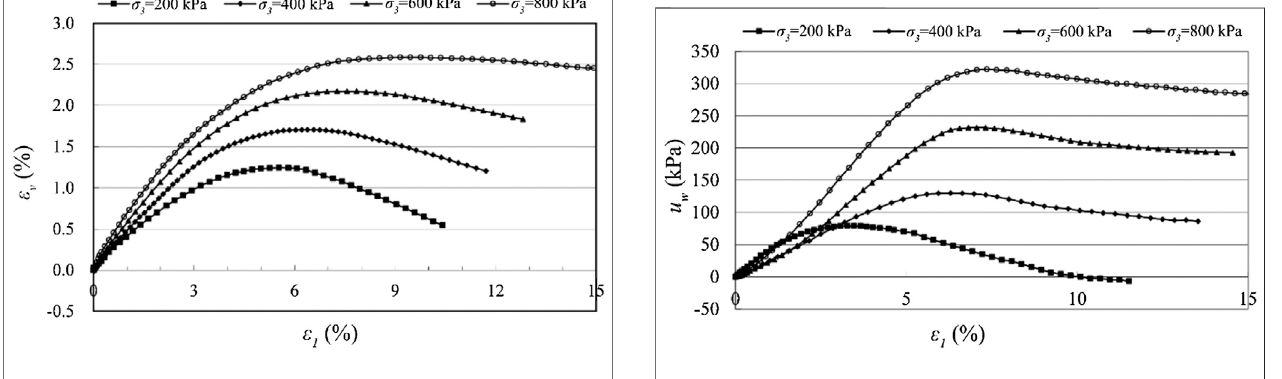
Frontiers in Physics |